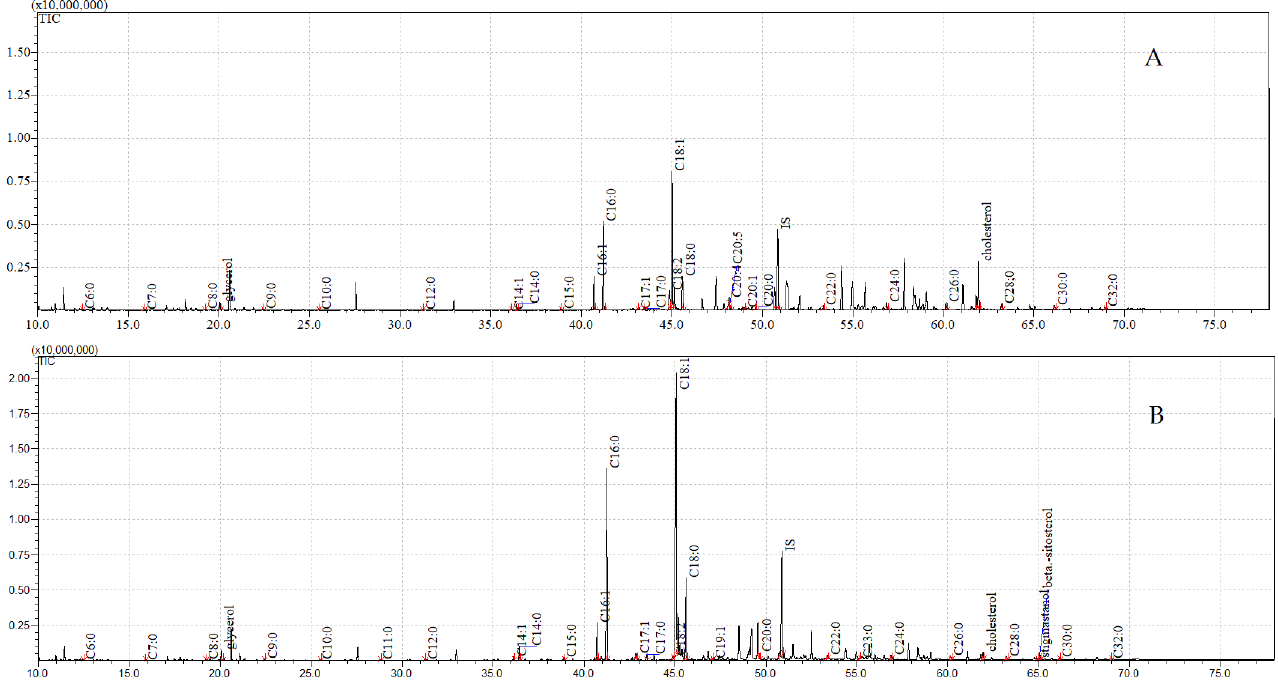
Figure 3. The total ion current (TIC) chromatogram of fatty acids (TMS esters) of the dichloromethane extract (extract II) from control (A) and after C. coronatus exposition (B) S. argyrostoma pupae . Internal standard (IS, 19 - methylarachidic acid); the following fatty acids and molecular ions: hexanoic acid (C6:0, m/z = 188), heptanoic acid (C7:0, m/z = 202), octanoic